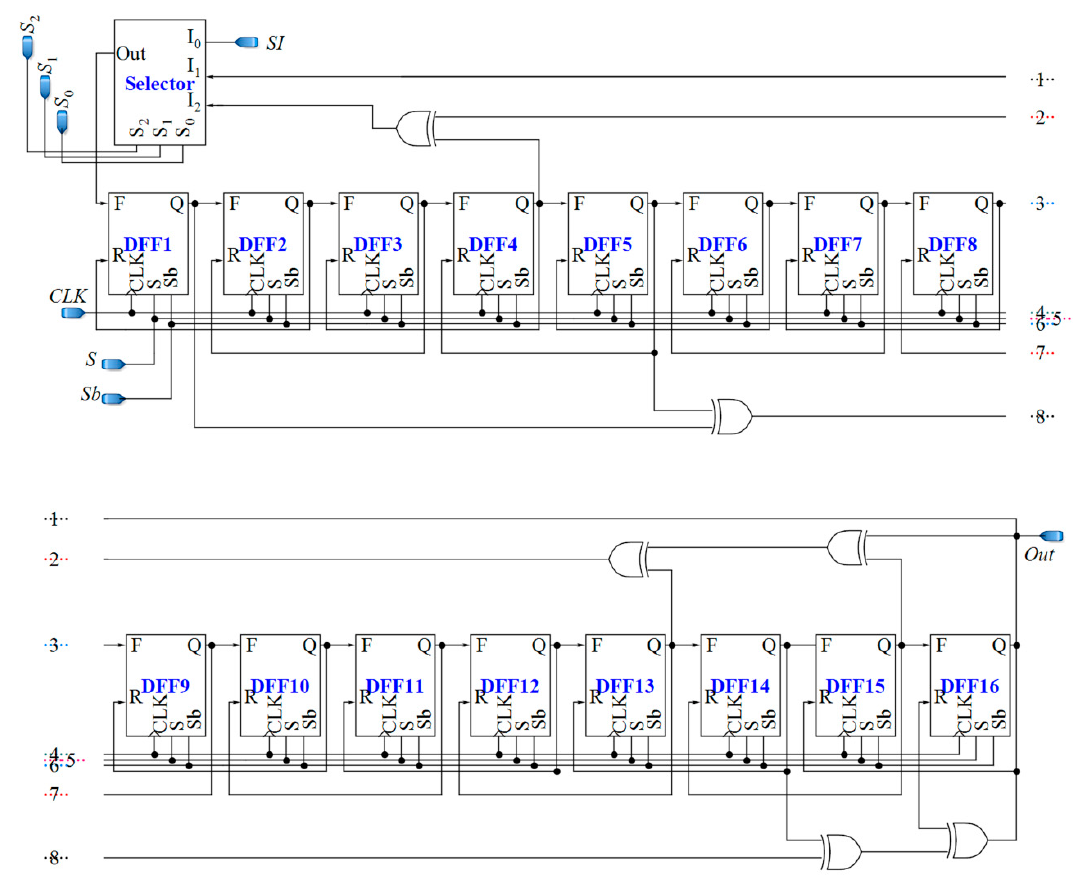
Figure 11. Proposed 16-bit LFSR-based reverse/forward counter/register.